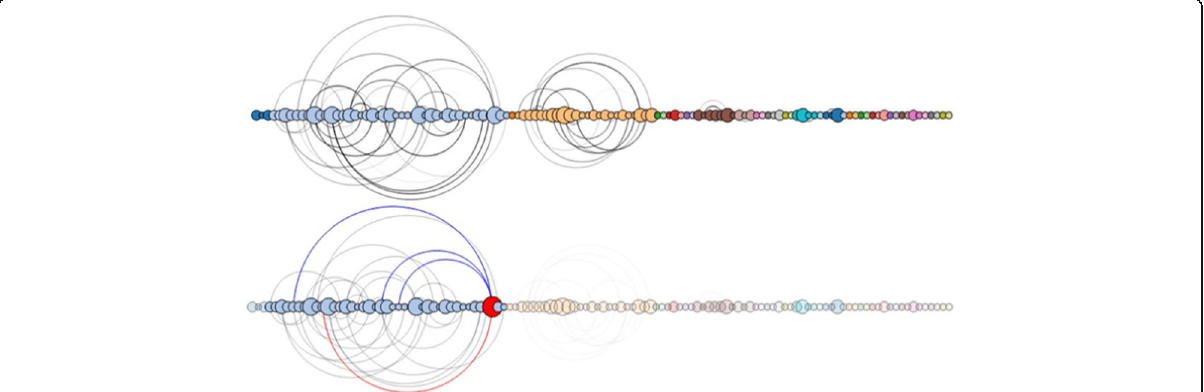
Fig. 4 Arc layout of the node-link diagram of the randomly generated dataset. Top: The initial arc diagram; Bottom: Filtered arc diagram [16]